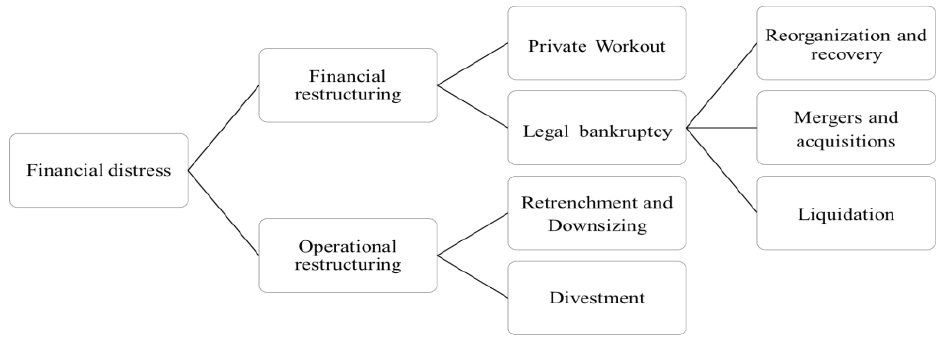
Figure 1: Organizational Financial Distress Trajectory and